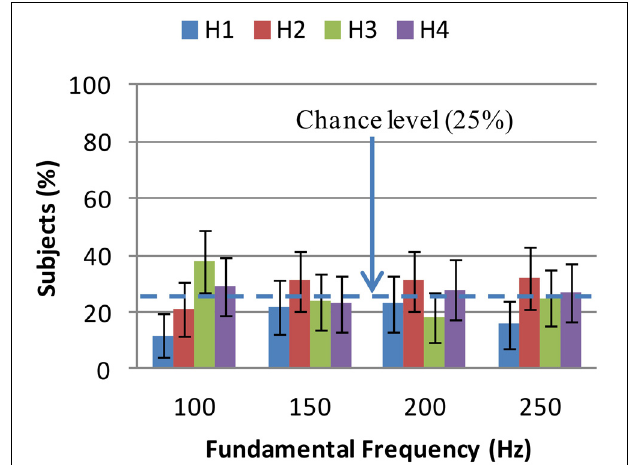
FIGURE 7 | Height selections for fundamental frequency: H1 is the lowest height and H4 is the highest one. No organized association between height and fundamental frequency is observed although H3 is the most selected height at 100Hz. At 150, 200, and 250Hz, all selection rates are nearly equal to chance level. The error bars show the 98.75% confidence intervals for all selection rates. Chance level is